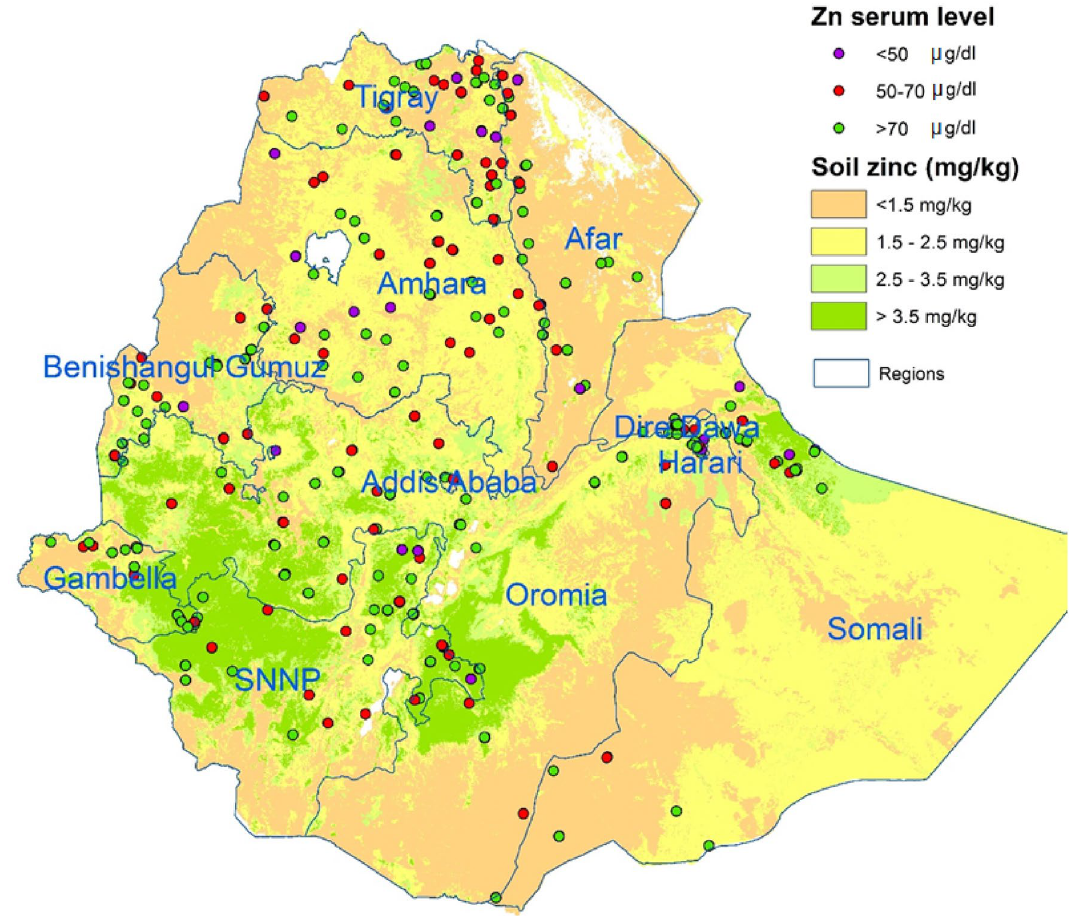
Figure 2. Map with soil zinc levels (AfSIS) and serum Zn levels in children under five years (ENMS) (map produced with ArcGIS Desktop version 10.8.1 from ESRI, https:// www. esri. com/ en- us/ arcgis/ produ cts/ arcgis- deskt op/ overv